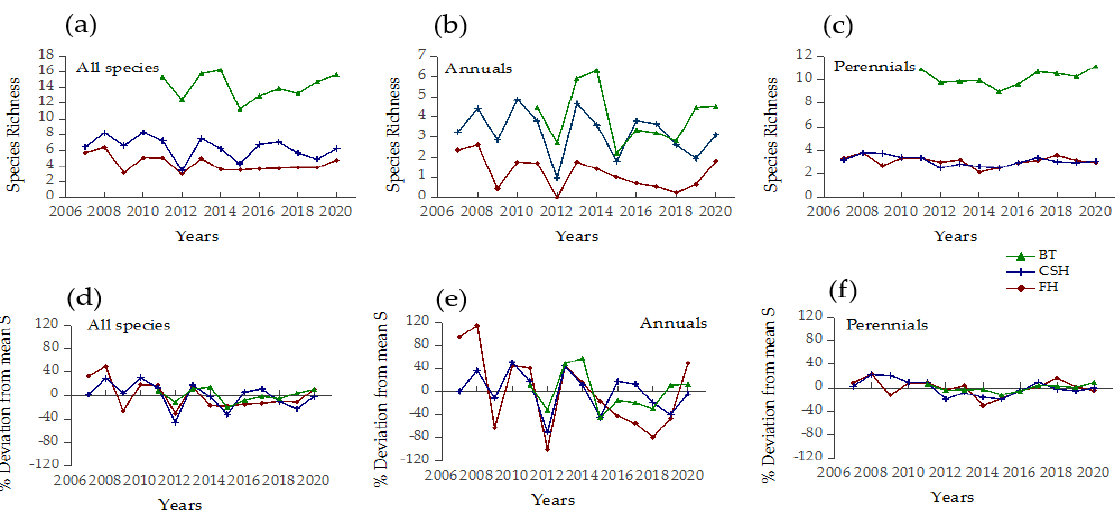
Figure 3. Temporal patterns of species richness observed at 2 m scale. BT = Battonya site (loess meadow steppe), CSH = Csévharaszt site (sand steppe 1), FH = Fülöpháza site (sand steppe 2). ( a – c ) Mean species richness; ( d – f ) Relative variability of species richness expressed as a percentage deviation from the temporal mean values. Mean values were calculated separately for each site.